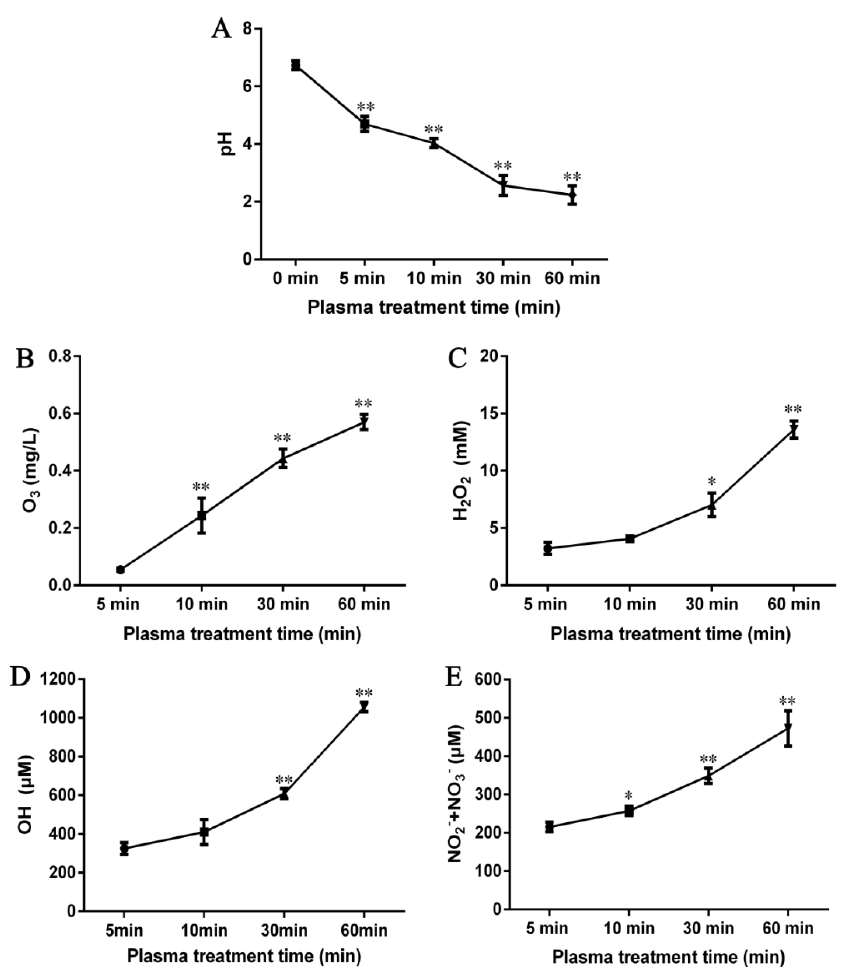
Figure 3. The pH value ( A ) and concentrations of O 3 ( B ), H 2 O 2 ( C ), •OH ( D ), and total NO 2− and NO 3− ( E ) in CJAP plasma with treatment times of 5 min, 10 min, 30 min, and 60 min. Data are presented as means ± SE ( n = 3) in the pH and reactive oxygen and nitrogen species (RONS) detection assays. Asterisks represent statistically significant differences from 5 min (* p < 0.05, ** p < 0.01).